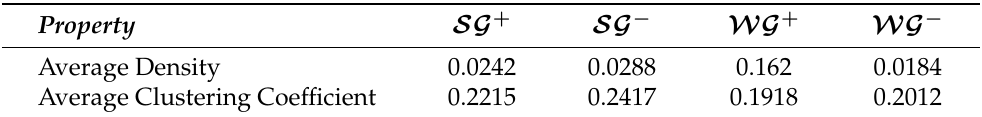
Table 7. Average values of density and average clustering coefficient for the graphs of type SG + , SG − , WG + and WG −